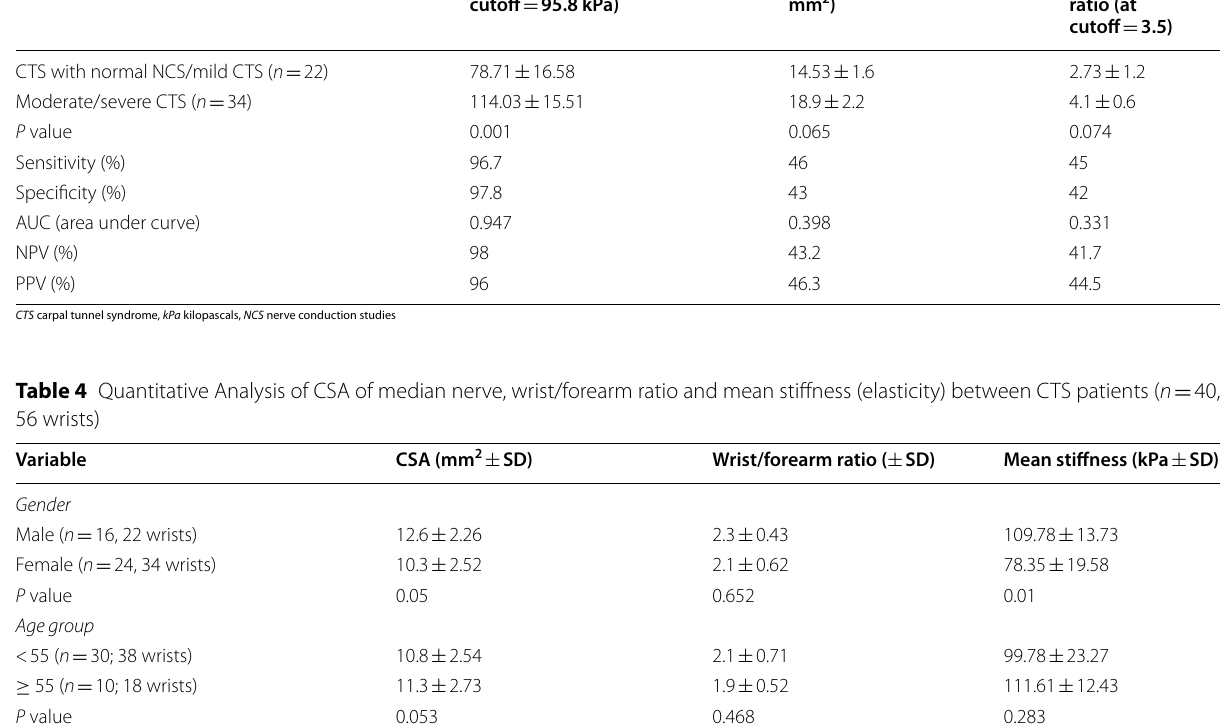
Table 3 Median nerve mean stiffness value by ultrasound elastography across CTS severity subgroups